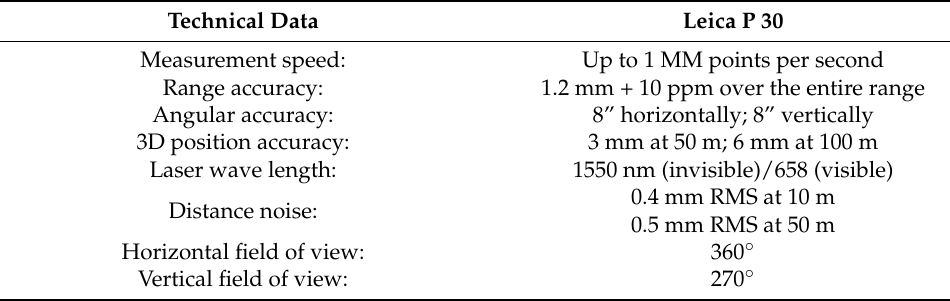
Table 2. TLS technical data—Leica